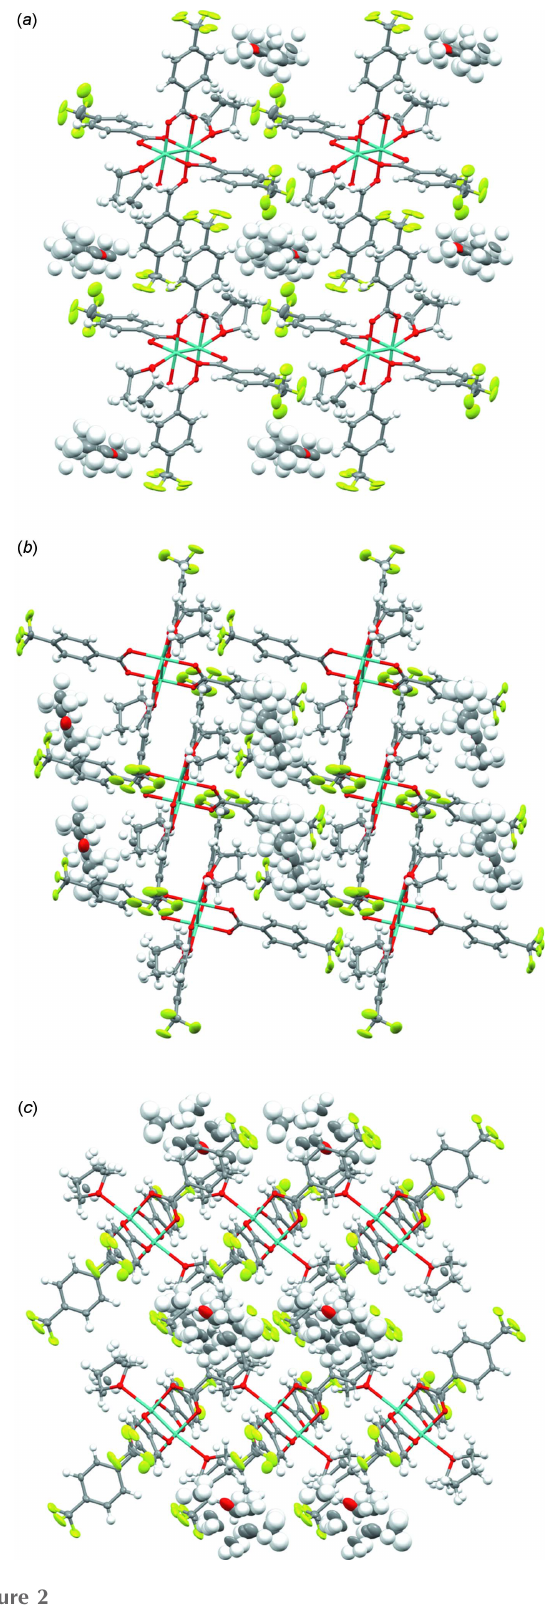
Figure 2 Crystal packing of the dimolybdenum complex shown along ( a ) the a -axis, ( b ) the b -axis and ( c ) the c -axis. The crystal has triclinic ( P 1) symmetry. Pentane and THF solvent molecules are present in the structure. Color scheme: C (gray), O (red), H (white), F (green), Mo